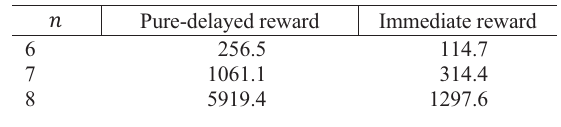
Table 1. The average training steps for two reward schemes when 𝑛 equals 6, 7, and 8